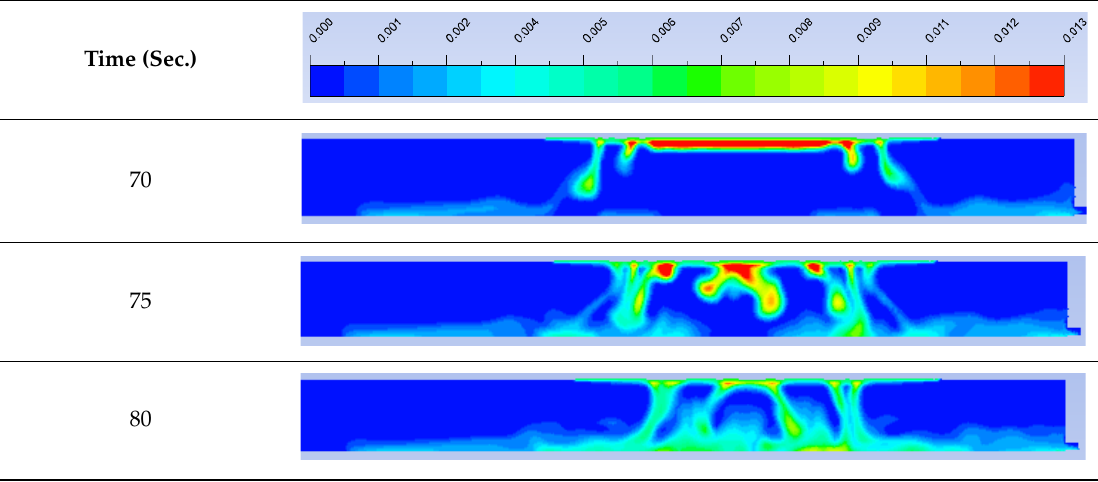
Table 6. Volume fraction contours for 500 µ m droplets.